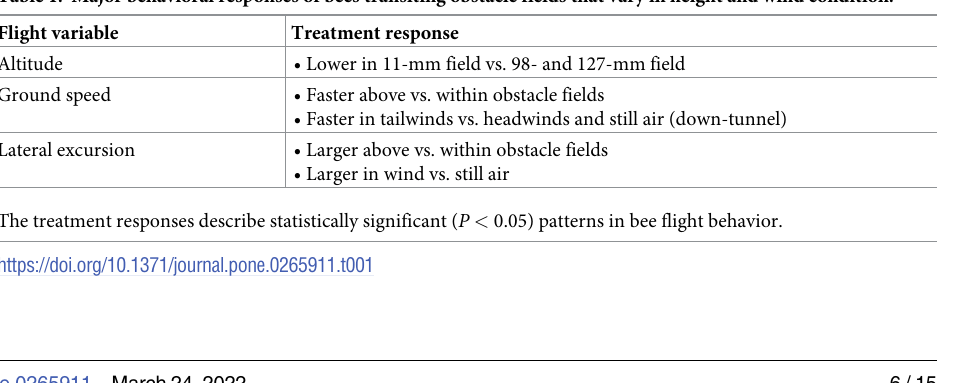
Table 1. Major behavioral responses of bees transiting obstacle fields that vary in height and wind